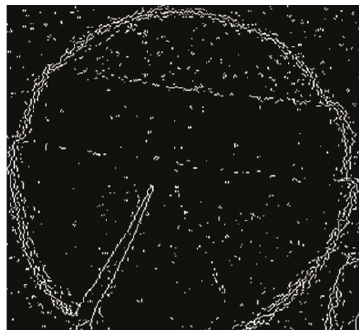
Figure 9: Image after edge detection using Prewitt operator.